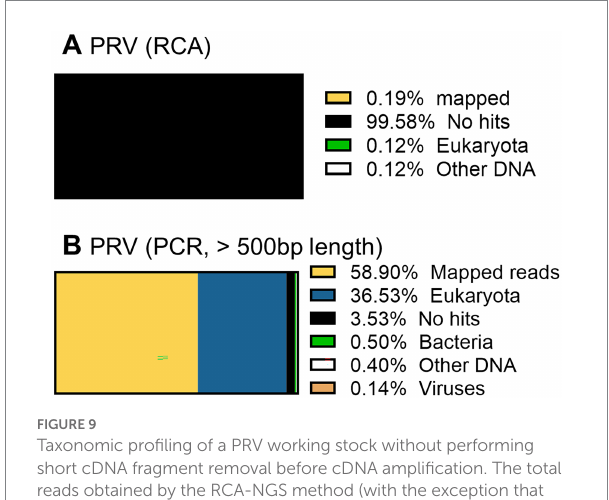
FIGURE 9 Taxonomic profiling of a PRV working stock without performing short cDNA fragment removal before cDNA amplification. The total reads obtained by the RCA-NGS method (with the exception that short reads were cut off) were analyzed using blastn for NT database (SE) on the Maser data analysis platform and MEGAN (A) . The total reads obtained by the PCR-NGS method were analyzed. The total reads obtained by the RCA-NGS method after cutting off the short reads (<500 bp) were also analyzed (B) . The percentage of reads categorized to the organism in the total reads is shown as a percentage bar chart, and the actual percentage is shown in the Figure